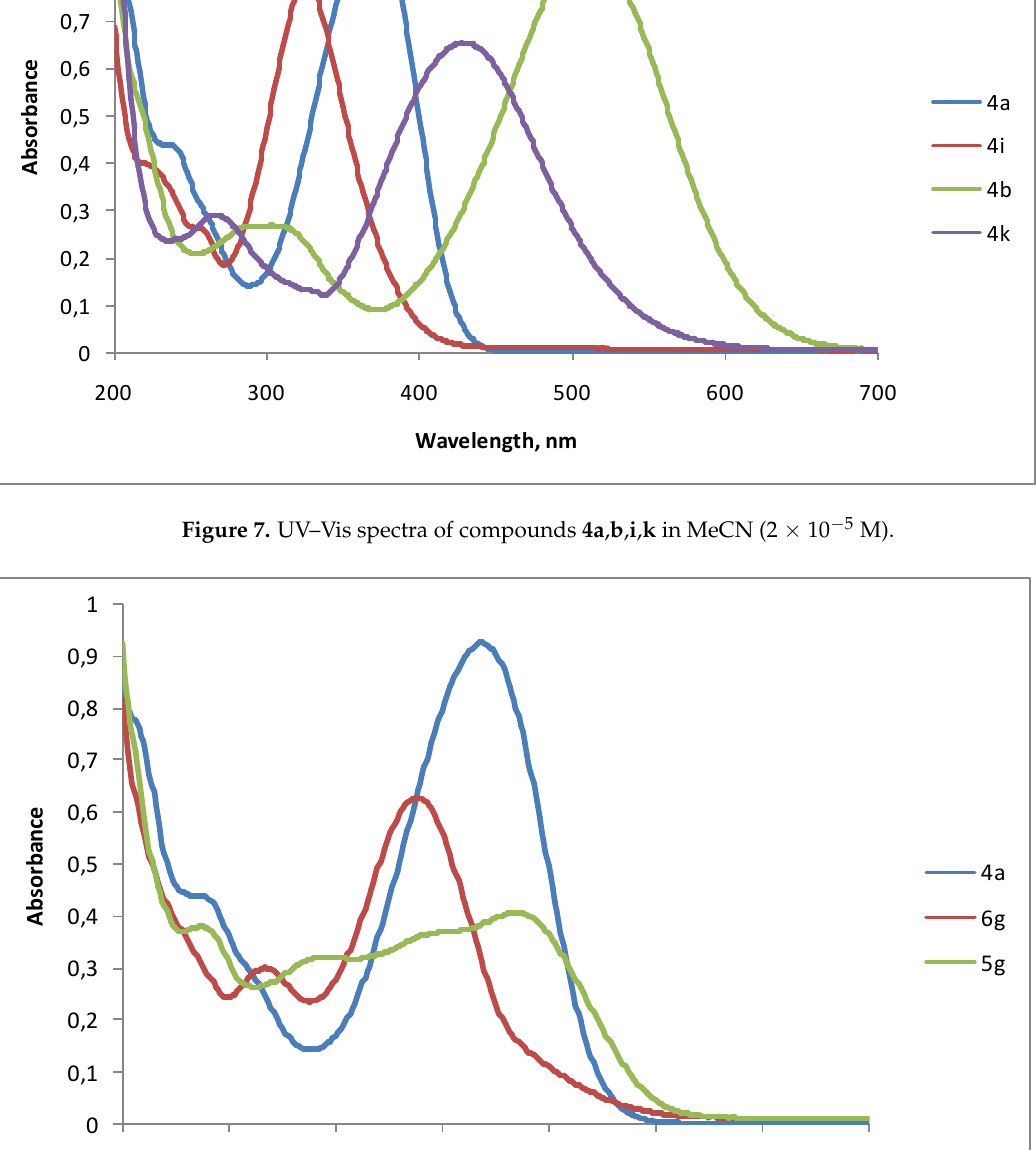
Figure 7. UV – Vis spectra of compounds 4a , b , i , k in MeCN (2 × 10 −5 M).